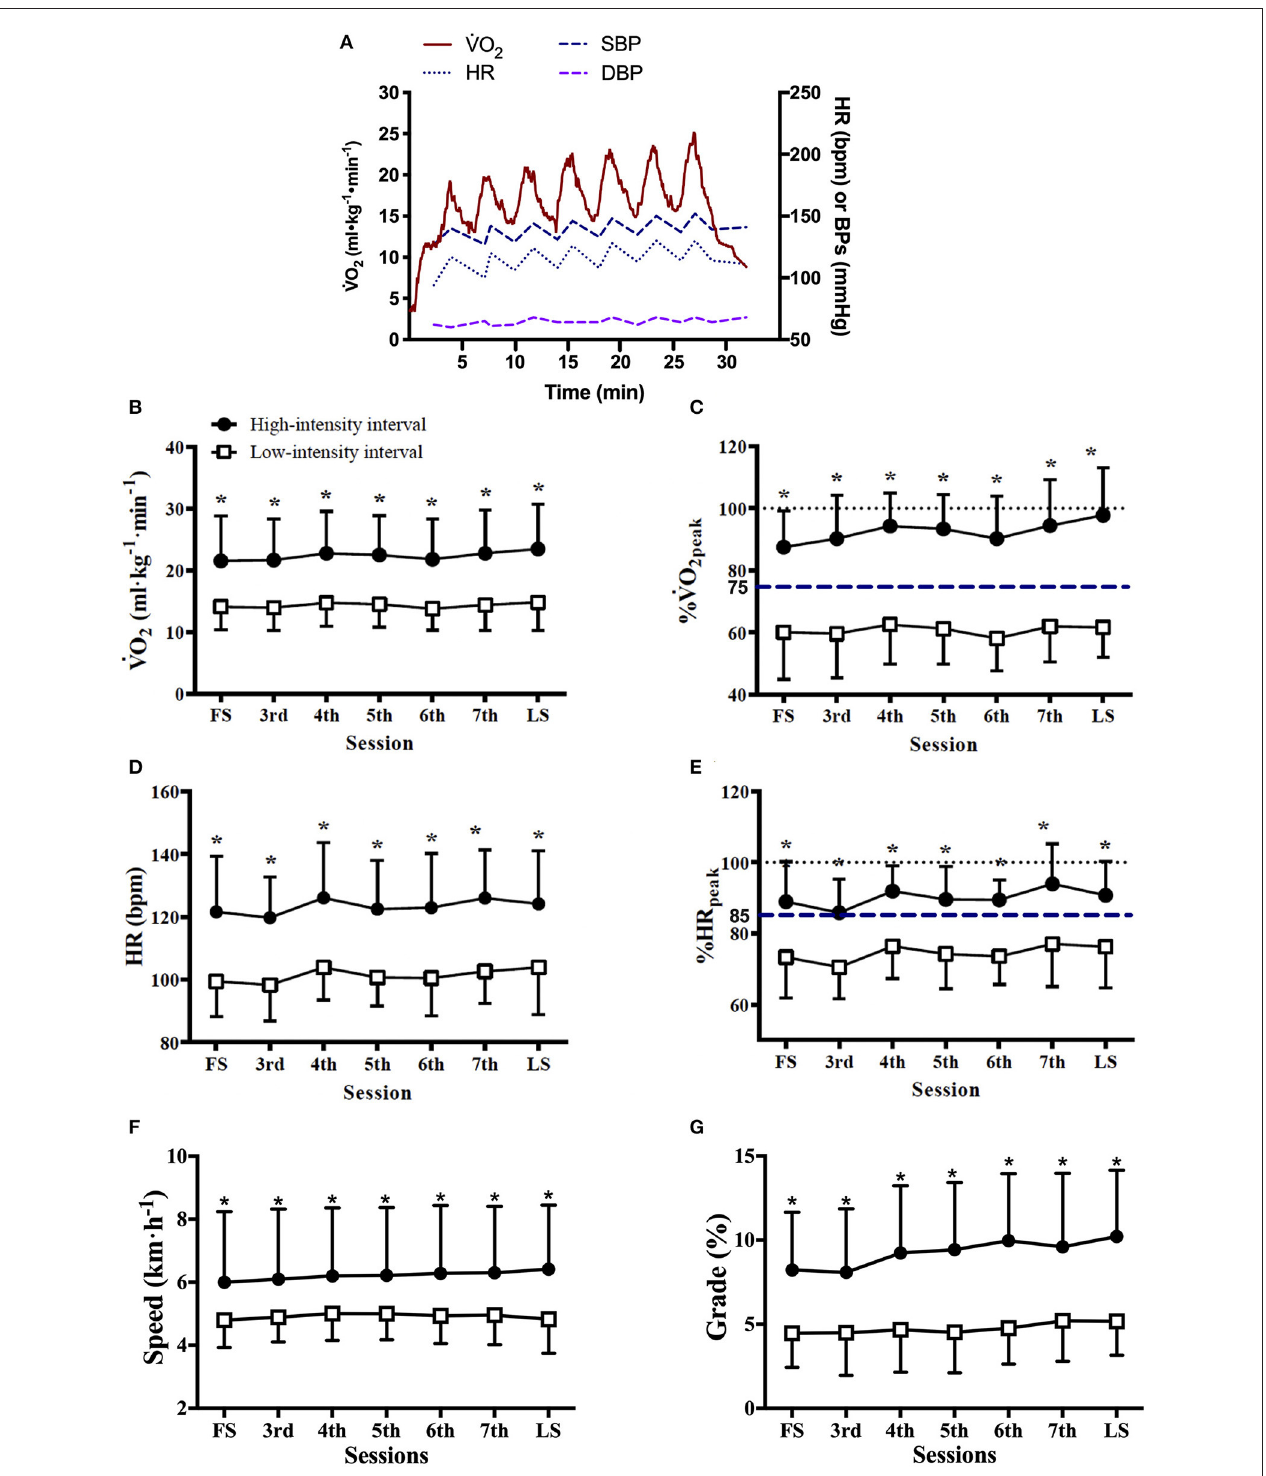
FIGURE 1 | Cardiorespiratory responses and treadmill workload during RPE-prescribed HIIT. (A) , a representative patient’s oxygen uptake (˙VO 2 ), heart rate (HR), systolic (SBP), and diastolic (DBP) blood pressure responses during a HIIT session. The average ˙VO 2 (B) , %˙VO 2peak (C) , HR (D) , %HR peak (E) , treadmill speed (F) , and treadmill grade (G) responses to the high- and low-intensity intervals over time. FS is the first exercise session. LS is the last exercise session. Repeated-measures ANOVA was used for all assessments. Data were expressed as mean + up limit of 95% confidence interval for high-intensity intervals and mean–low limit of 95% confidence interval for low-intensity intervals in (B–G) . *Significantly higher than low-intensity interval, p < 0.001.